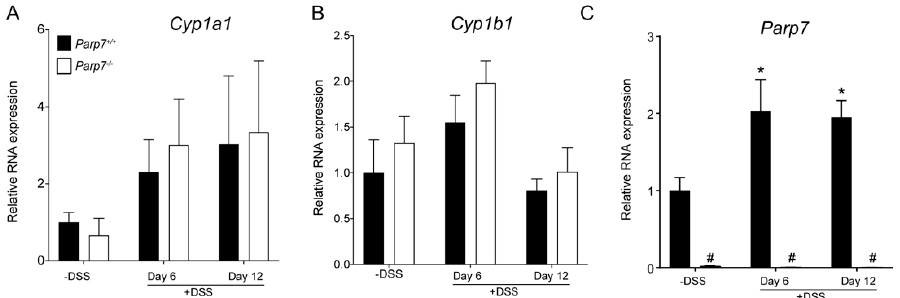
Figure 5. Parp7 , but not Cyp1a1 and Cyp1b1 expression levels are increased in response to DSS. The expression levels of ( A ) Cyp1a1 and ( B ) Cyp1b1 in colonic tissue are unaffected by genotype or exposure to 2% DSS in drinking water. ( C ) Parp7 expression is induced in colon tissue isolated from DSS treated Parp7 +/+ mice. * p < 0.05 two-way ANOVA compared with genotyped-matched and DSS treated animals. # p < 0.05 two-way ANOVA compared with time matched Parp7 +/+ mice.